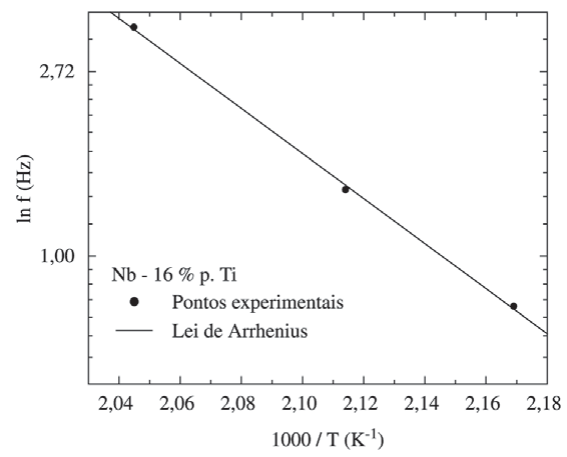
Figura 3. Logaritmo da freqüência em função do inverso da temperatura para o processo de relaxação observado na amostra da liga Nb –16% p.